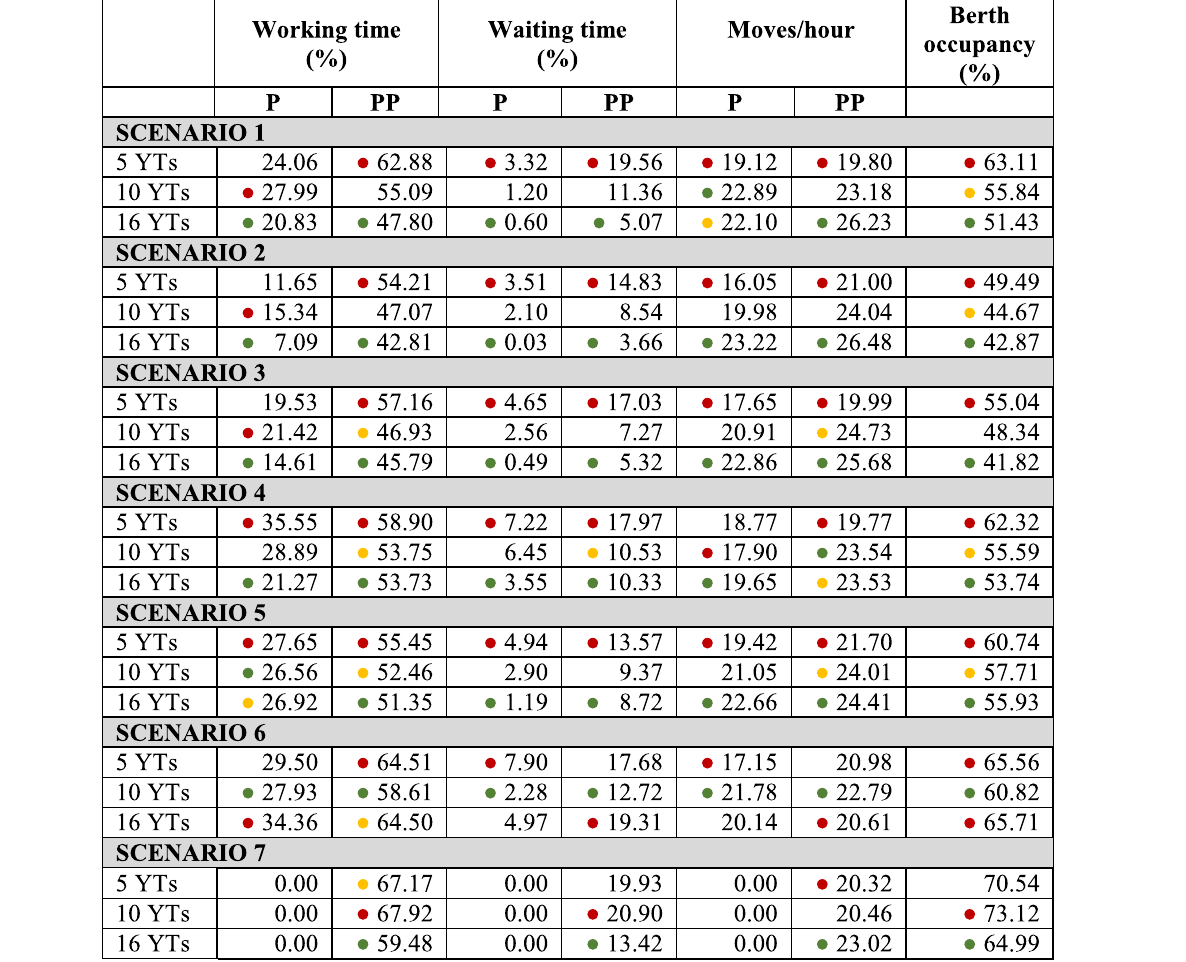
Table 3 Results of the operations at the berth subsystem (three simulation sets) with different number of